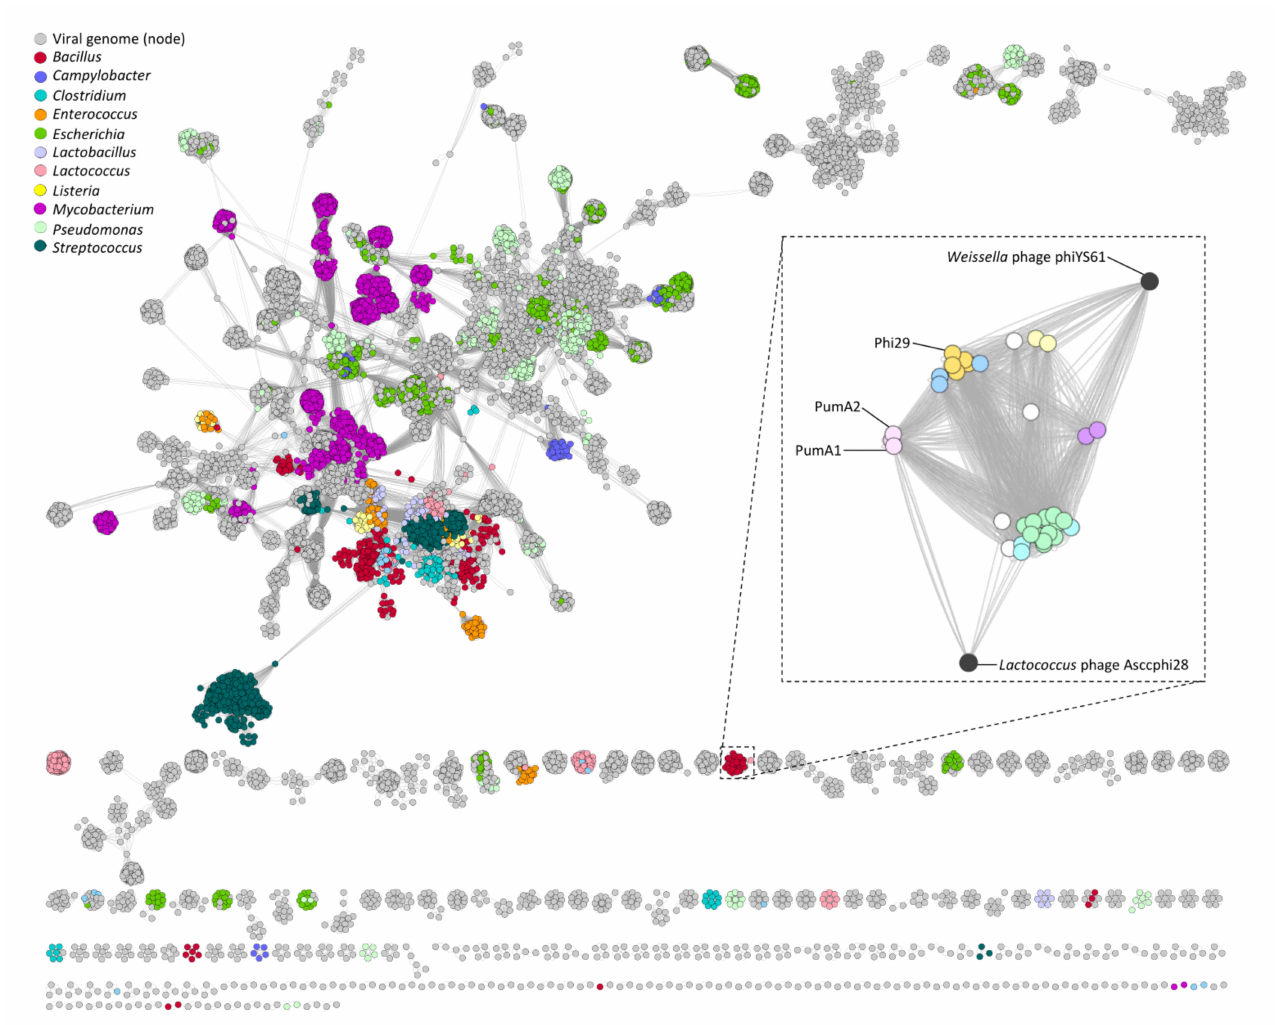
Figure 6. vConTACT2 reticulate genome network of phages in the Genbank and ICTV databases. A “node” or singular phage genome is connected by an “edge” or line which is calculated by how many proteins they share and is scored by significance. The Salasmaviridae /phi29-like phages cluster was extracted in the dotted box. The network is displayed using an edge-weight spring embedded layout that repels phages based on their lack of similarity in protein cluster